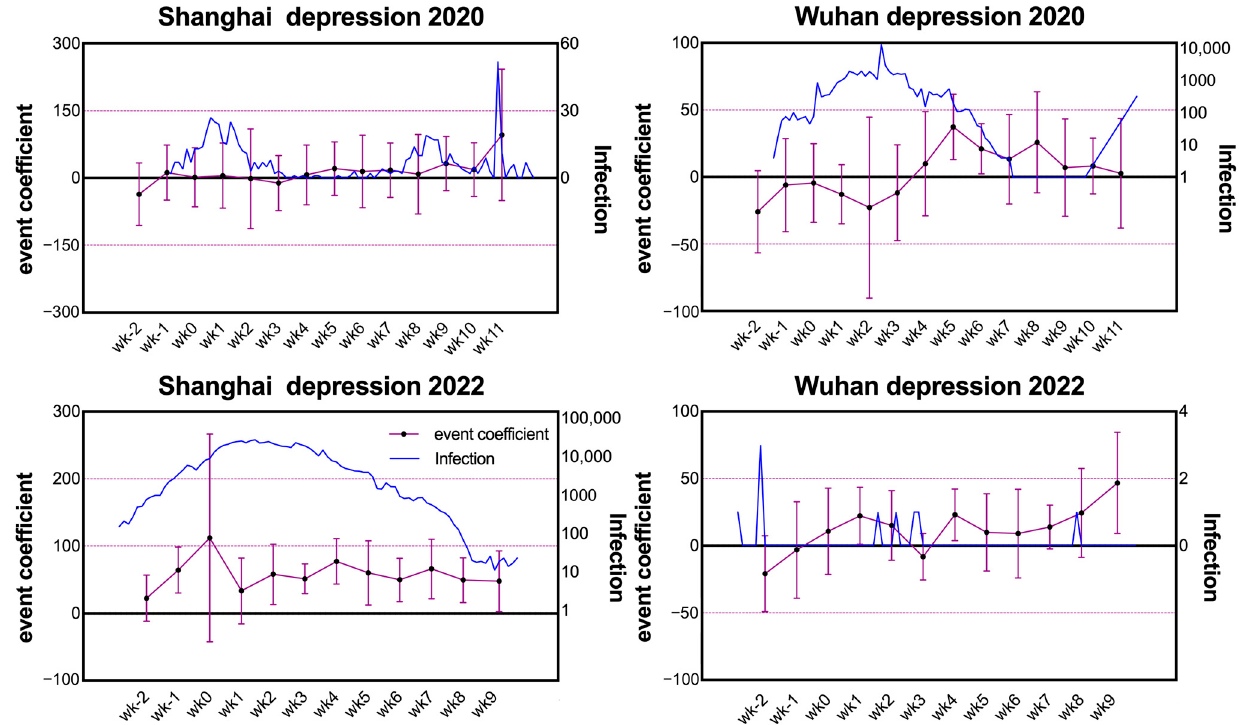
Figure 4. Trend of α k / β k for depression, Shanghai vs. Wuhan, Figure 4. Trend of 𝛼 (cid:3038) /𝛽 (cid:3038) for depression, Shanghai vs. Wuhan, 2019–2022.